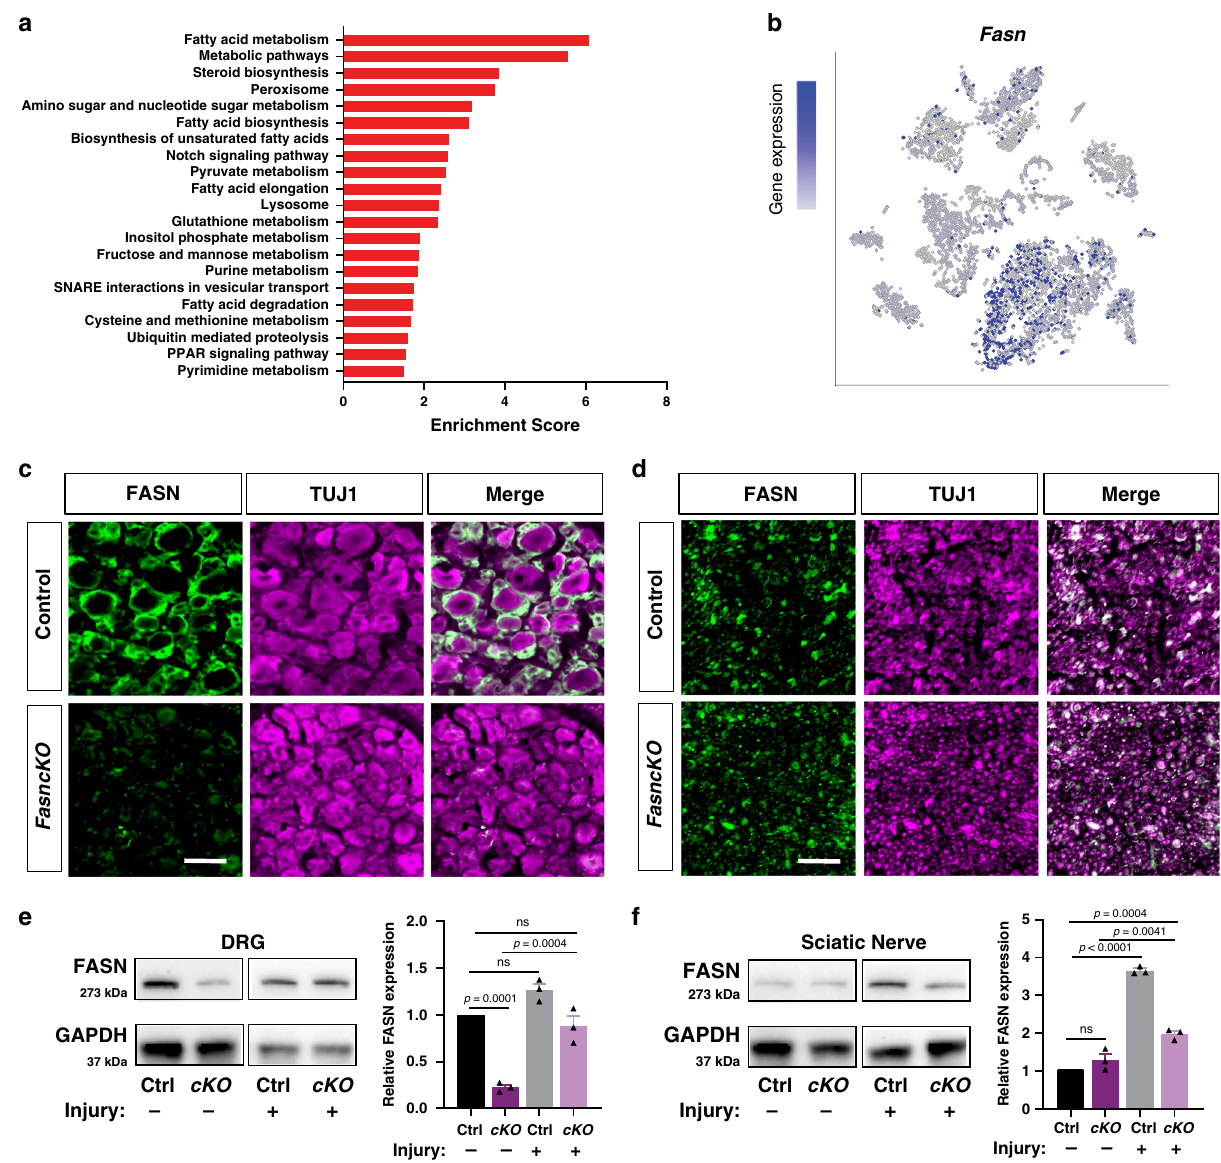
Fig. 3 SGC upregulate genes involved in lipid metabolism in response to nerve injury. a Pathway analysis (KEGG 2016) of differentially upregulated genes in the SGC cluster. n = 2 biologically independent experiments. (FDR < 0.05, Log2Fold change >2). b t-SNE overlay for expression of Fasn gene. c DRG sections from control and FasncKO mice, immunostained for FASN (green) and the neuronal marker TUJ1 (magenta). Scale bar: 50 µ m. d Nerve sections from control and FasncKO mice, immunostained for FASN (green) and the neuronal marker TUJ1 (magenta). Scale bar: 50 µ m. e Western blot analysis and quanti fi cation of FASN protein expression in DRG from control and FasncKO mice with and without injury. Quanti fi cation of FASN expression normalized to GAPDH expression. ns-non signi fi cant. Source data are provided as a Source Data fi le. f Western blot analysis and quanti fi cation of FASN protein expression in Sciatic nerve from control and FasncKO mice with and without injury. Quanti fi cation of FASN expression normalized to GAPDH expression. ns-non signi fi cant. Source data are provided as a Source Data fi le. n = 3 biologically independent animals in ( e , f ). Data are presented as mean values ± SEM in ( e , f ). One way ANOVA followed by Dunnett ’ s multiple comparisons test in ( e , f